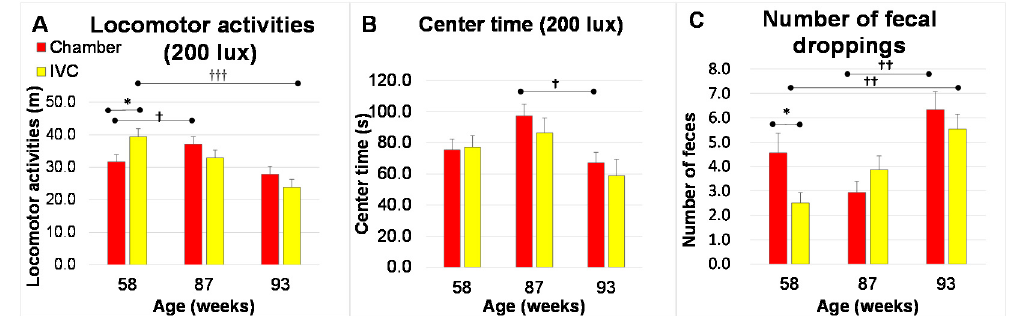
Figure 9. Changes in behaviors in open field test under 200 lux with aging in the chamber and IVC groups (Test 7): ( A ) Locomotor activities; ( B ) Center time; ( C ) Number of fecal droppings. Between-group comparison: * p < 0.05 by t-test, Within-group comparison : ††† p < 0.001; †† p < 0.01; † p < 0.05 by one-way ANOVA followed by Tukey’s post hoc test.